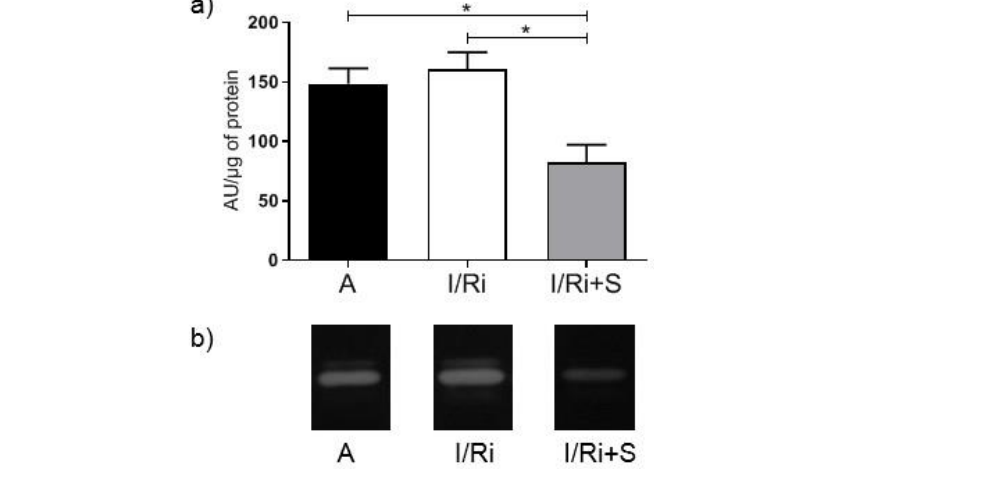
Figure 2. Matrix metalloproteinase 2 (MMP-2) activity in hearts subjected to ischemia-reperfusion ( a ) The MMP-2 activity in heart tissue samples subjected to I/R. Gelatin zymography showed significant differences in MMP-2 activity in hearts of group treated with simvastatin compared to I/Ri group without simvastatin. MMP-2 activity expressed in arbitrary units per µ g of protein. * p < 0.05, n = 5–6, ANOVA. ( b ) Representative zymogram showing MMP-2 gelatinolytic activity in heart tissue.